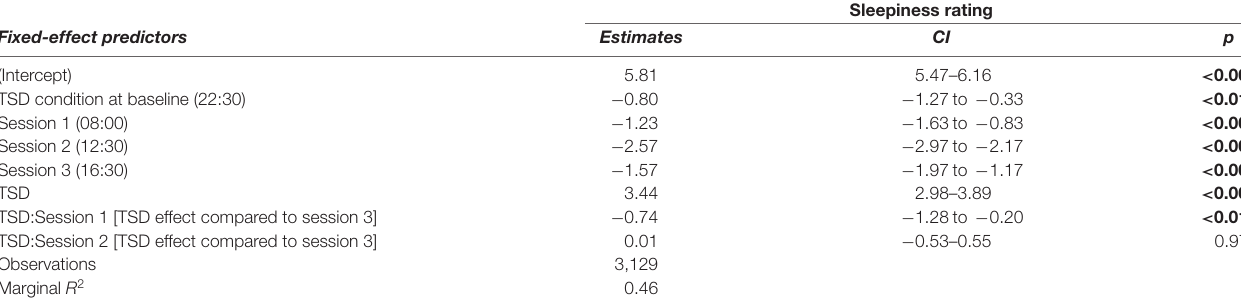
TABLE 6 | Subjective sleepiness score predictions based on sleep condition and time-of-day effects in the final mixed-effects model.